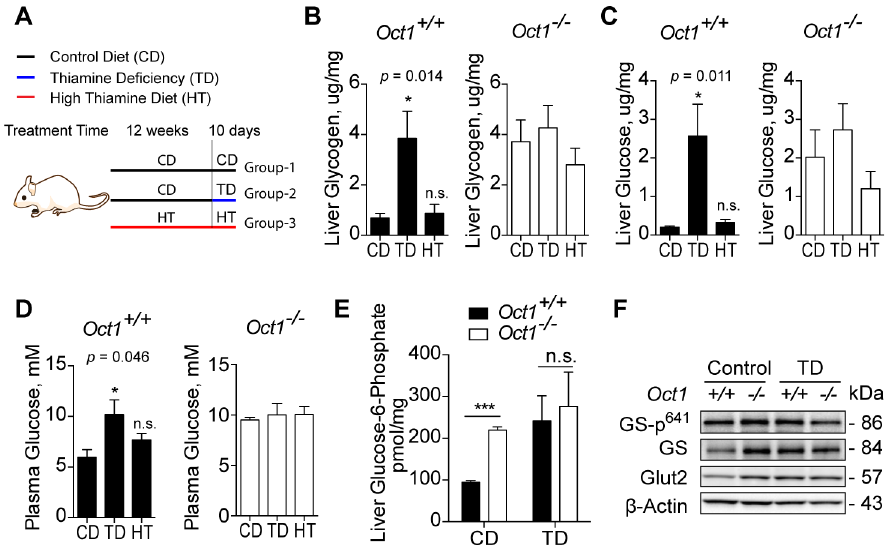
Fig 5. Different thiamine treatments affected glucose metabolism. (A) Scheme of experimental design. Two groups of mice (Group-1 and Group-2) were treated with a CD, 5 mg/kg, and one group (Group-3) with an HT, 50 mg/kg, to the end of the experiment. The third group of mice (Group-2) was treated with a CD but switched to a TD, 0 mg/kg, for 10 days. After dietary treatment, mice were fasted overnight for 16 hours before being humanely killed ( n = 4 per genotype in each treatment). (B) Hepatic glycogen content quantification. (C) Hepatic glucose content quantification. (D) Plasma glucose quantification. For (B–D), CD, TD, and HT indicate diet received by the mice during the final 10 days of treatment. (E) Hepatic glucose-6-phosphate content quantification. (F) Representative western blots of protein expression in enzymes involved in energy metabolism; protein was pooled from 4 mice per genotype. Data shown are mean ± SEM. Data were analyzed by ordinary one-way ANOVA and p -value is stated, and Dunnett’s post hoc test was used to compare to the control (CD) group for (B), (C), and (D). Data were analyzed by unpaired two-tailed Student t test for (E); (cid:3) p < 0.05, (cid:3)(cid:3) p < 0.01, and (cid:3)(cid:3)(cid:3) p < 0.001. Underlying data are provided in S1 Data. CD, thiamine controlled diet; Glut2, glucose transporter 2; GS, glycogen synthase; GS-p 641 , phospho-glycogen synthase at serine 641; HT,